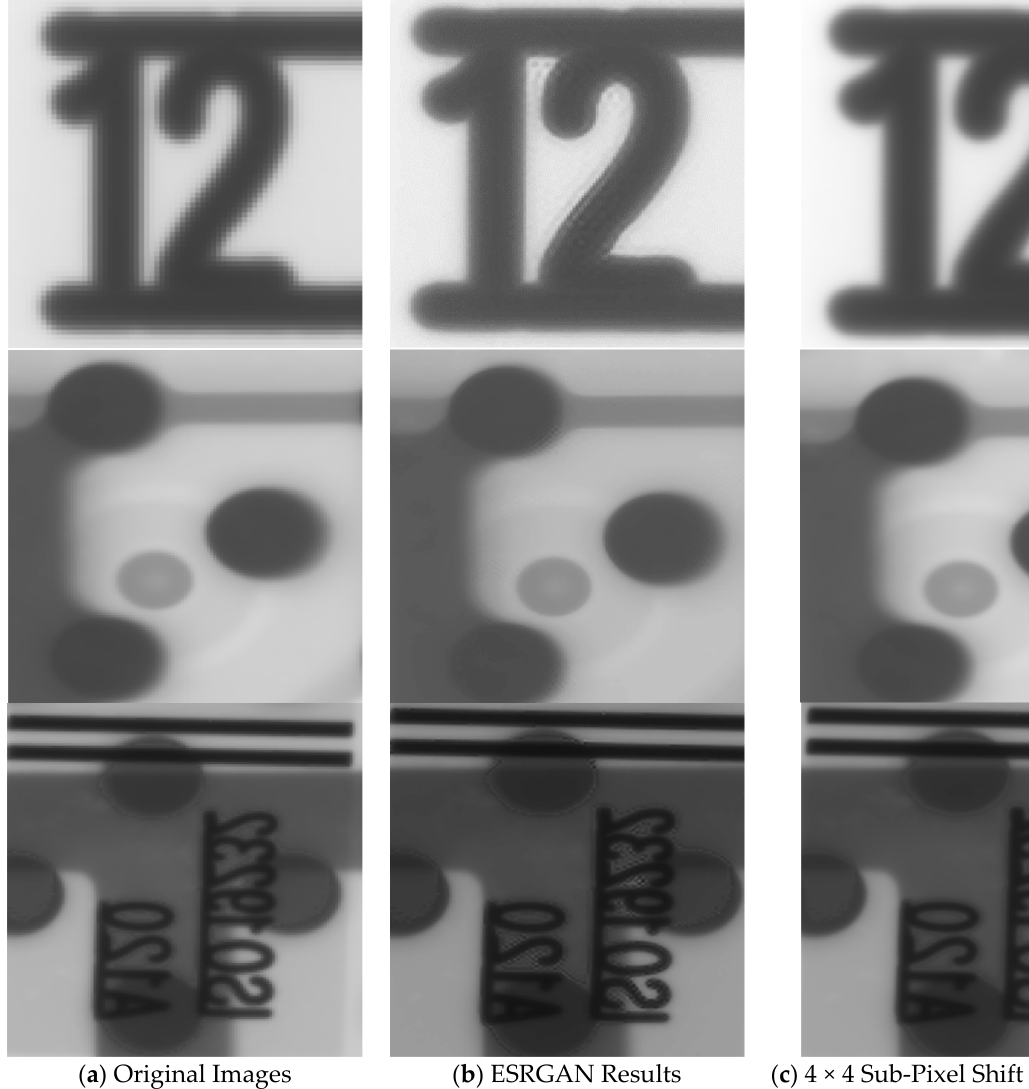
Figure 13. The results of the ESRGAN algorithm and ours on real object images. ESRGAN improves the overall spatial resolution but introduces local artifacts and noise. The arrows indicate artifacts produced by ESRGAN